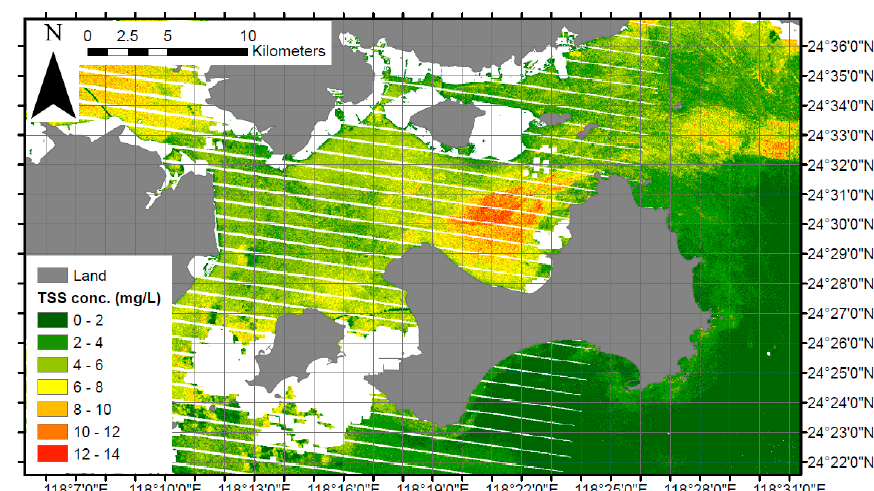
Figure 7. Distribution of TSS concentration on 10 August 2018 derived by the model of Table 5.